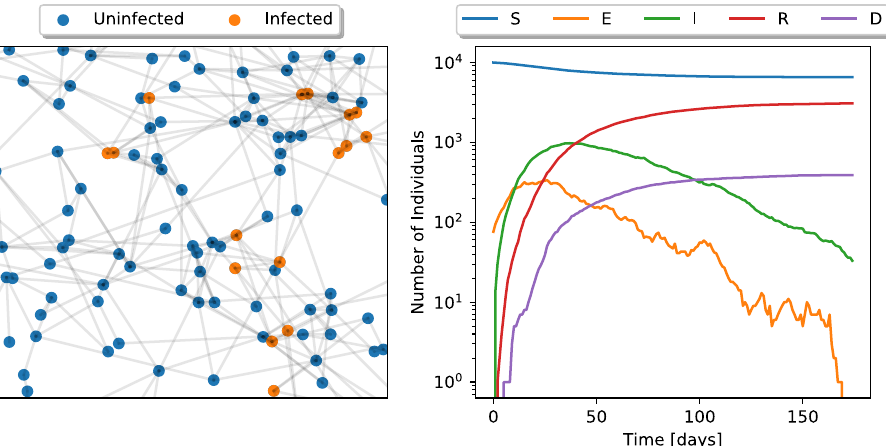
Figure 5. (Left) Depiction of the graph connecting the population, and the individuals infected or left uninfected over the course of the simulation. (Right) Aggregated numbers of individuals in each disease state over the course of the simulation. We see that due to the network’s sparsity, the disease only propagates through a subset of the population, affecting just ∼ 30% of